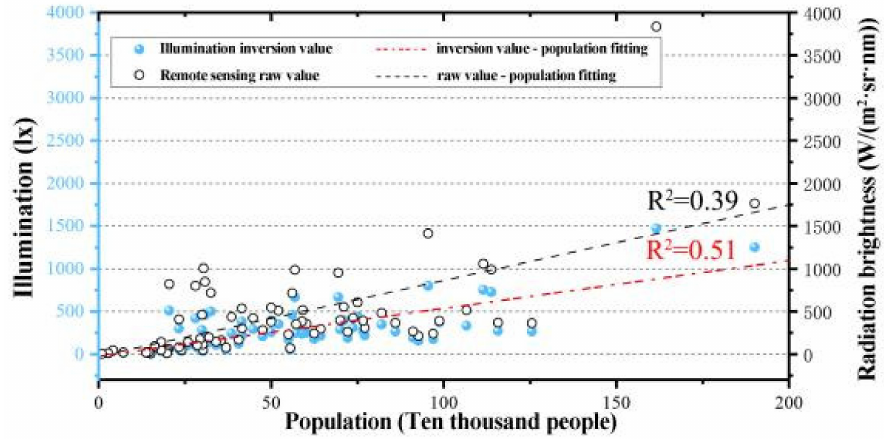
Figure 16. Scatter plot of total population, total radiance and total inversion illuminance of each street.